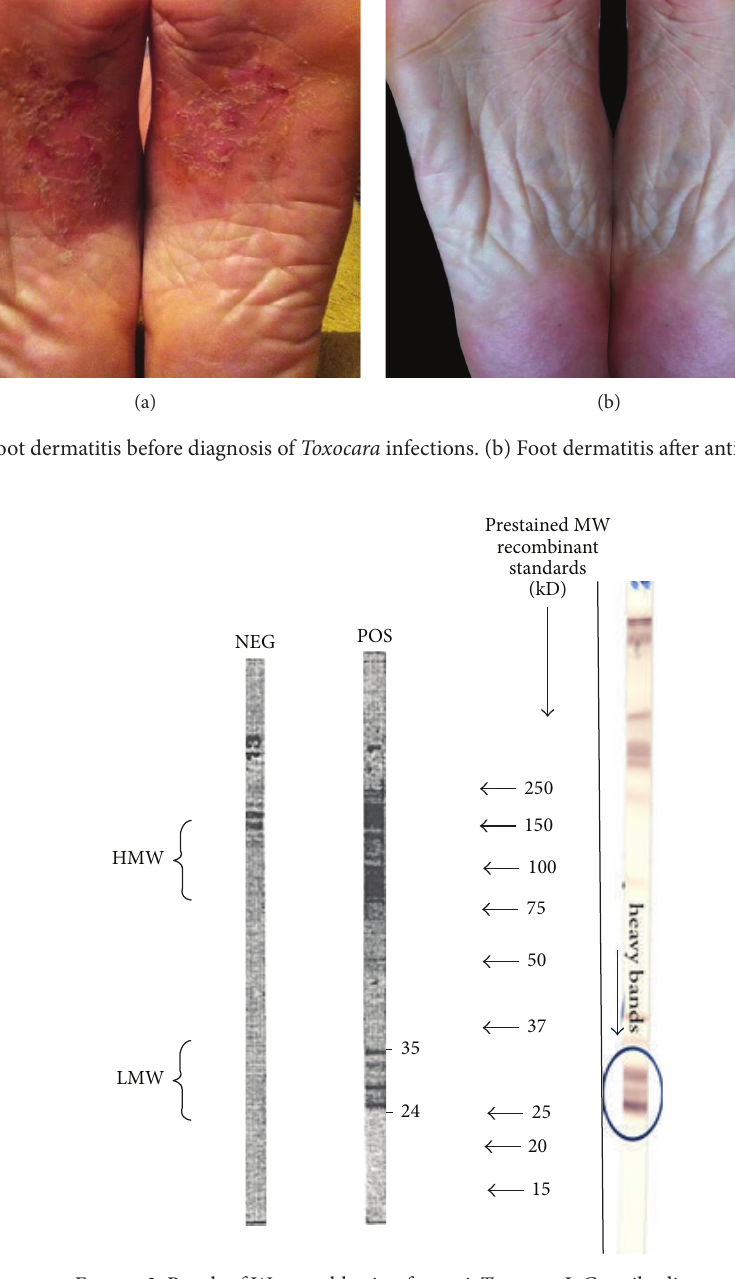
Figure 2: Result of Western blotting for anti- Toxocara IgG